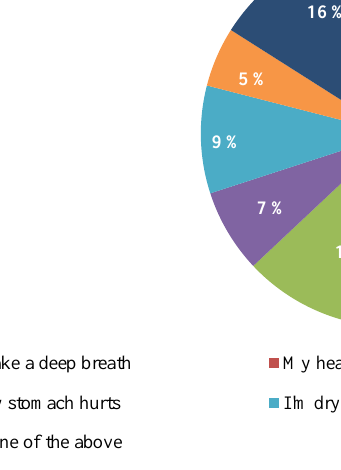
Fig. 7. Answers to the question: How do you feel immediately after leaving the office